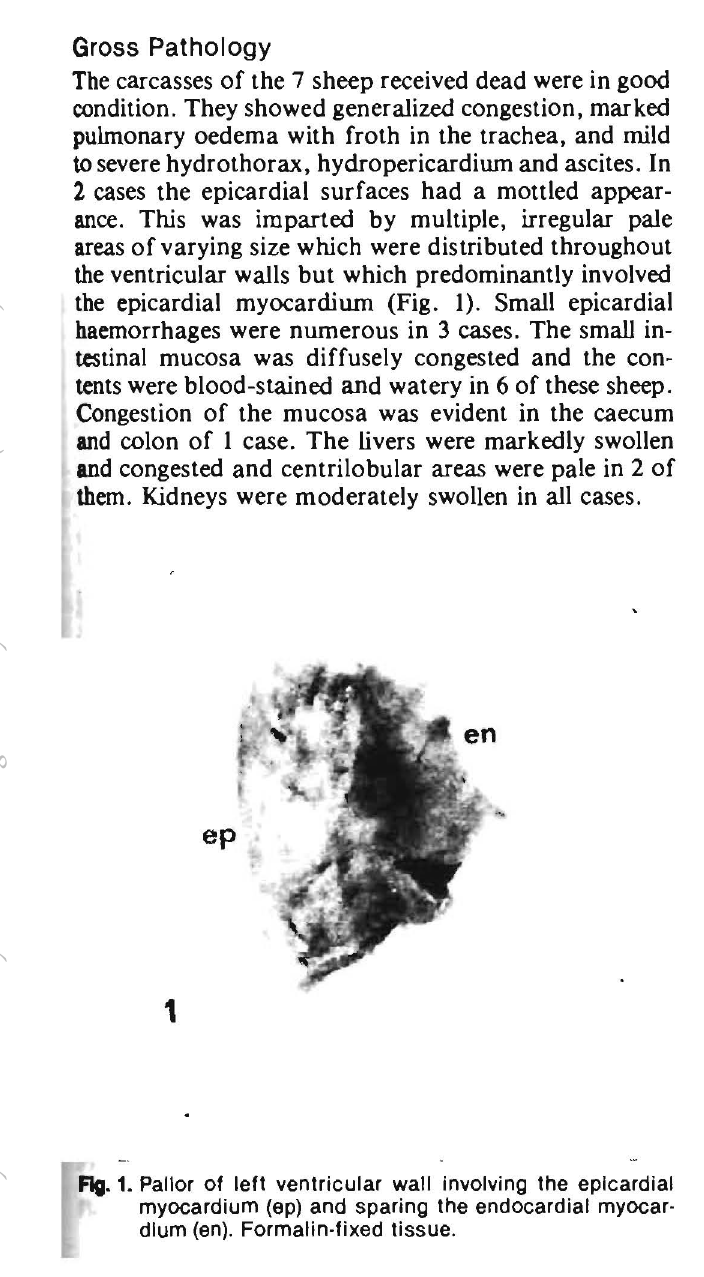
fig. 1. Pallor of left ventricular wall involving the epicardial myocardium (ep) and sparing the endocardial myocar· dlum (en). Formalin·fixed